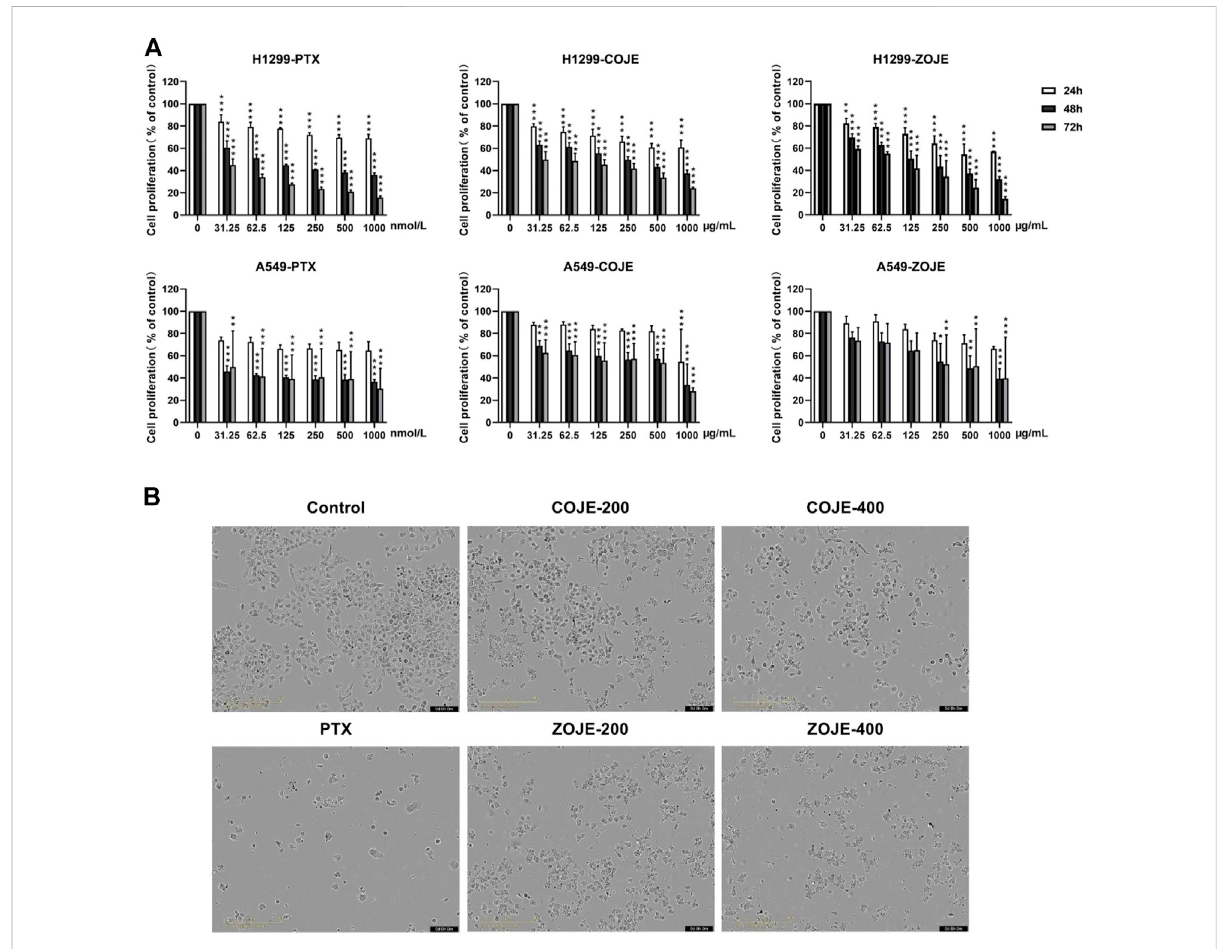
FIGURE 2 CellproliferationofNCI-H1299andA549cellsafterOJEtreatment.( A )NCI-H1299andA549cellswereexposedtoOJE(0 – 1000 μ g/ml)orPTX (0 – 1000 nmol/L) for 24 – 72 h, and cell proliferation was determined utilizing MTT assay. ( B ) Morphological changes of NCI-H1299 cells after treatmentwithvehicle,OJE(200,and400 μ g/ml)orPTX(500 nmol/L)for48 h.Scalebar:100 μ m.Theexperimentaldataareexpressedasthemean value with SD of three independent replicates. (* p < 0.05, ** p < 0.01, *** p < 0.001, compared to